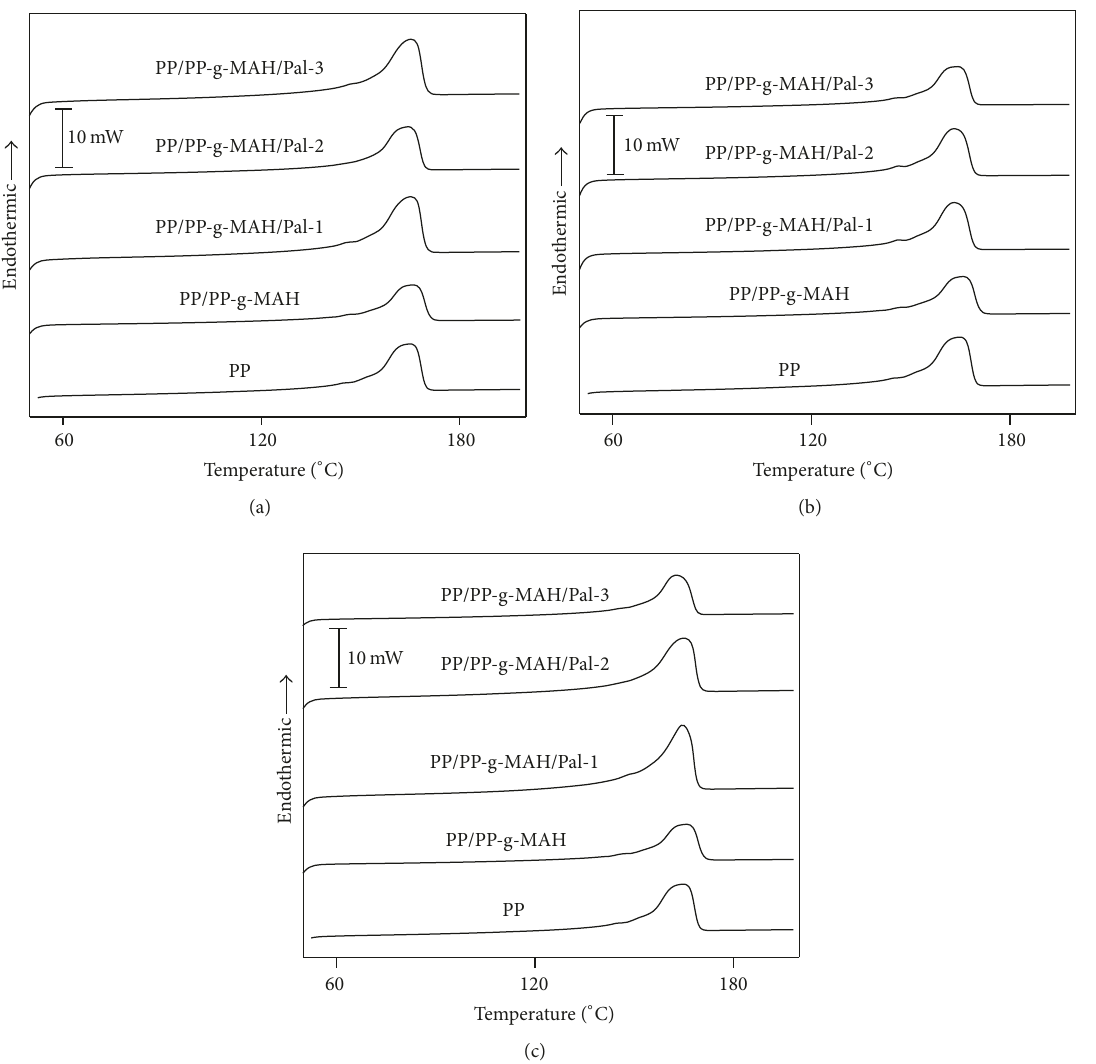
Figure 8: DSC thermograms for PP, PP/PP-g-MAH, and PP/PP-g-MAH/Pal: (a) 0.5, (b) 1, and (c) 2wt.% Pal content, respectively.